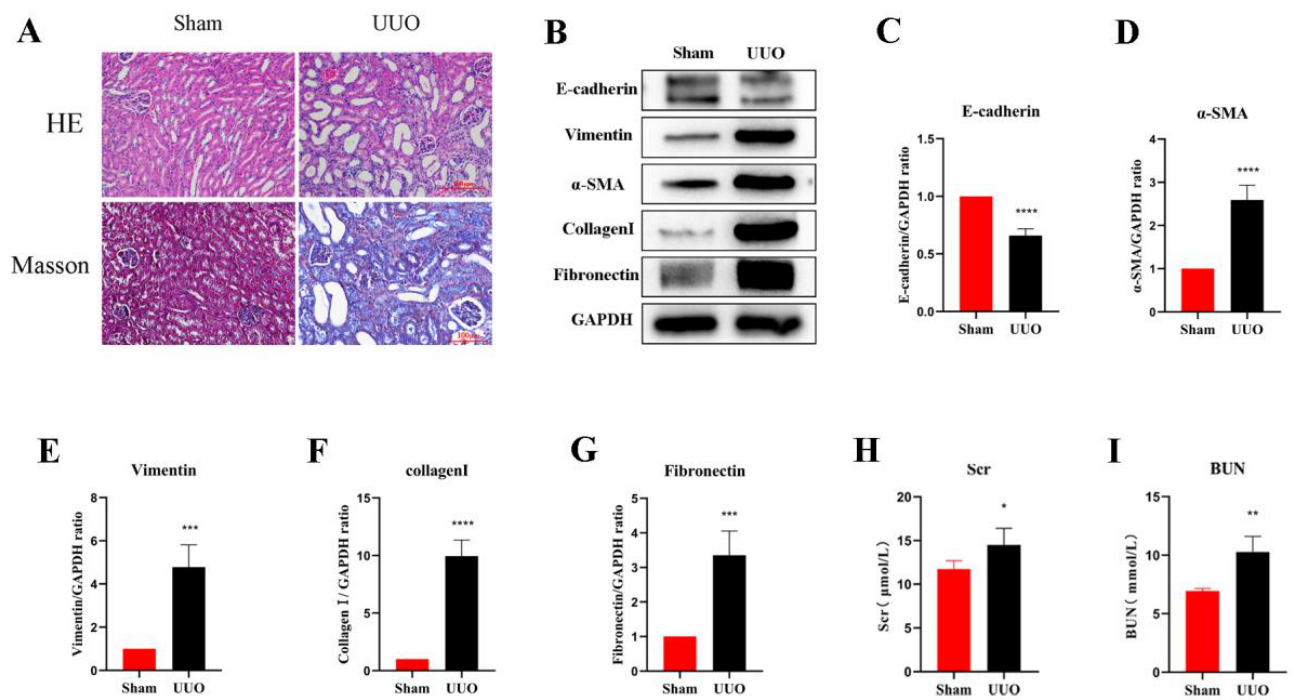
Figure 1. Renal fibrosis models established by UUO. ( A ) Histomorphology (including H&E and Masson staining) of the kidneys in both groups (scale bar: 100 µ m). ( B – G ) Analysis of E-cadherin, Vimentin, α -SMA, Collagen I, and Fibronectin relative protein levels by Western blot in both groups. ( H , I ) Levels of biochemical parameters (Scr and BUN) in both groups. Protein levels were normalized with GADPH. * p < 0.05, ** p < 0.01, *** p < 0.001, **** p < 0.0001.